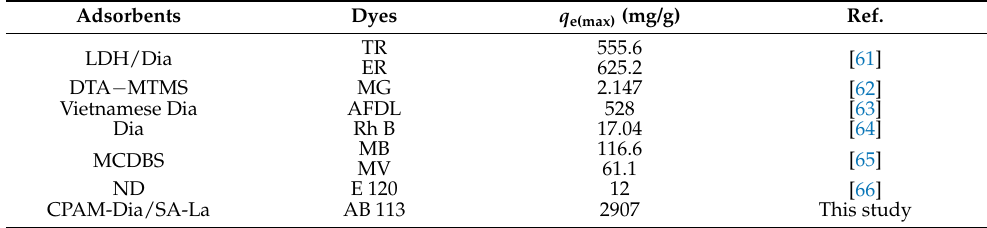
Figure 4. Comparison of adsorption properties of different materials ( a ); Effect of regeneration cycle times on regeneration rate ( b ). Table 4. Maximum adsorption capacities of Dia-based adsorbents for